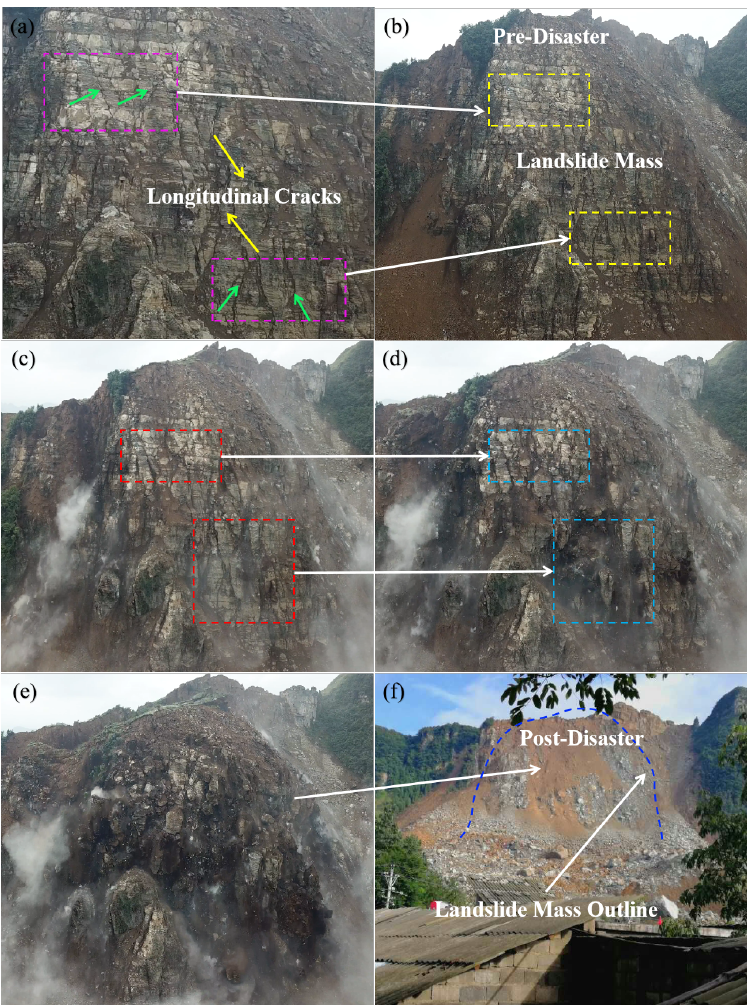
Figure 13. Landslide process: ( a ) the surface fissures of DCB; ( b ) fissures developed on the surface of DCB before the disaster; ( c ) fissures when DCB began to collapse; ( d ) fissures that develop as the DCB collapses; ( e ) collapsing DCB; ( f ) post-disaster